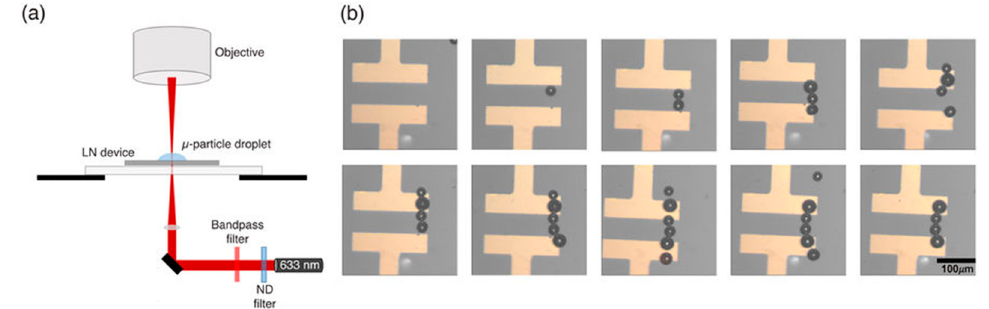
Figure 10. Schematic of the experimental setup ( a ), and demonstration ( b ) of one ‑ by ‑ one micro ‑ solder ‑ bead assembly between two gold electrodes deposited on z ‑ cut LiNbO 3 crystal. Taken from Sperling et al. Sci. Rep. 2017 , 7 , 9660 (reference [49]).